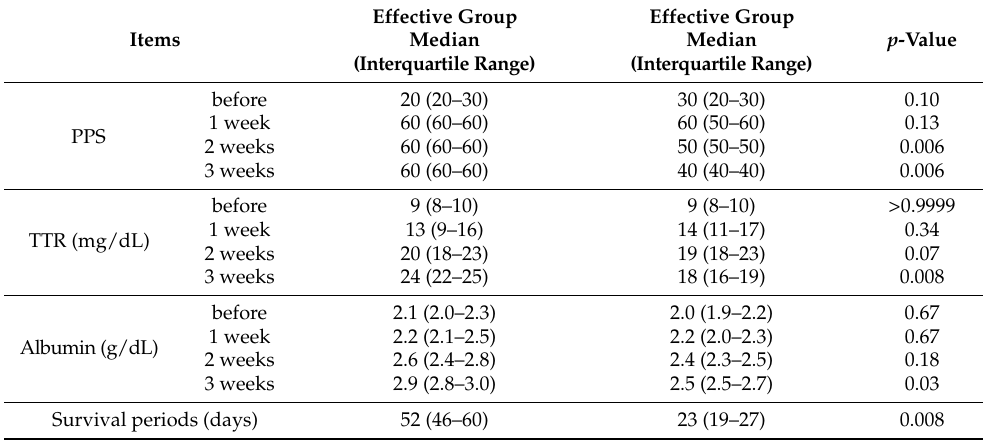
Table 3. Comparison of the data after nutritional intervention. Items